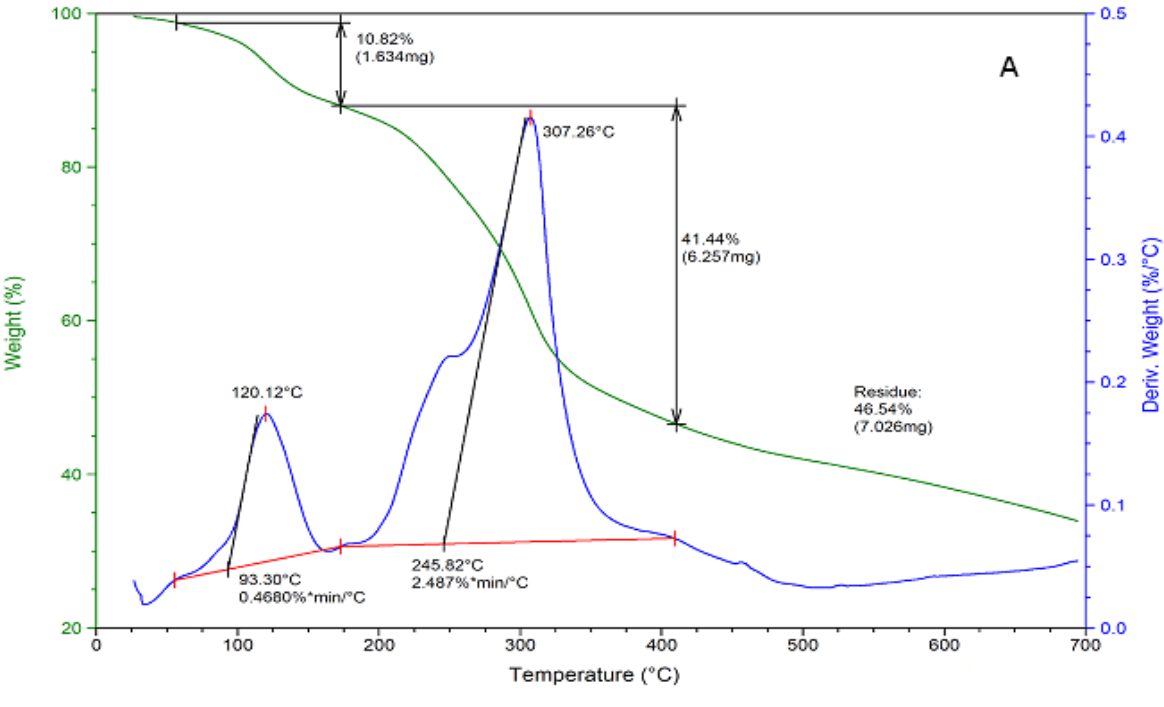
Figure 1. TGA ( A ) and DSC ( B ) of the Ru-carnosine